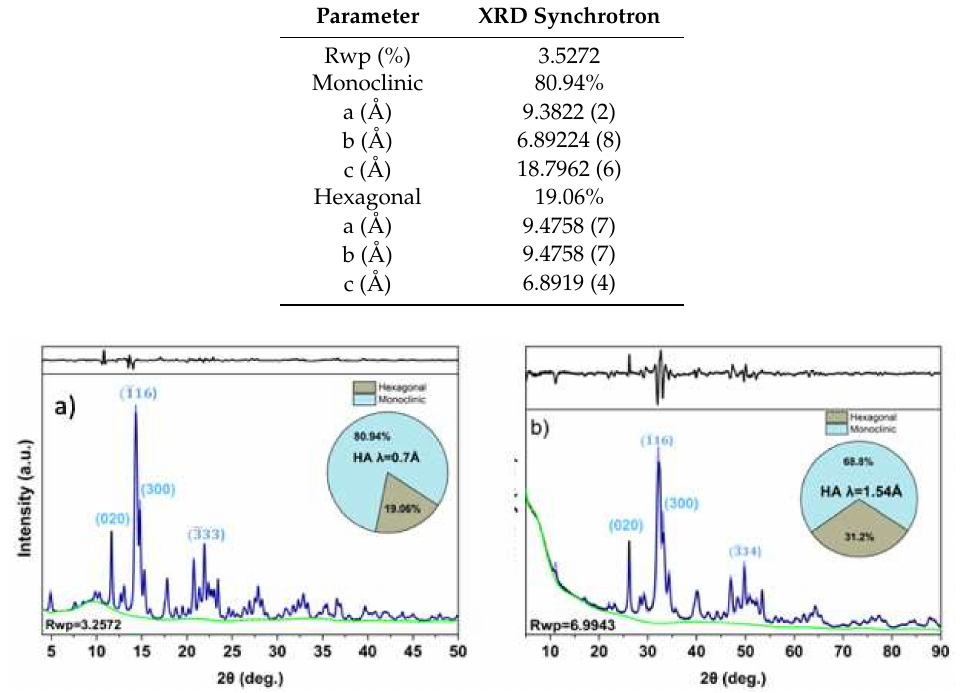
Figure 3. ( a ) Room temperature XRD pattern of HA powder sample collected with λ = 0.7 Å (synchrotron radiation); ( b ) Cu K α ( λ = 1.54 Å) patterns. In case of the SR data, there is a